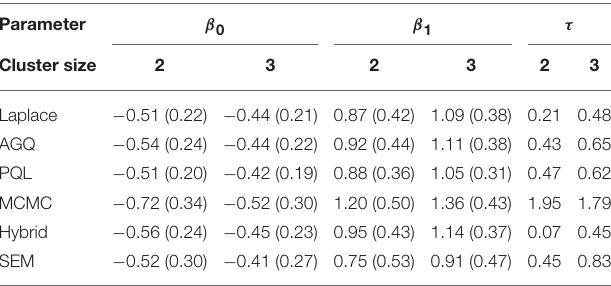
TABLE 1 | The estimates (and (robust) standard errors) from the six approaches for the intercept β 0 , the slope parameter β 1 and the random intercept variance τ